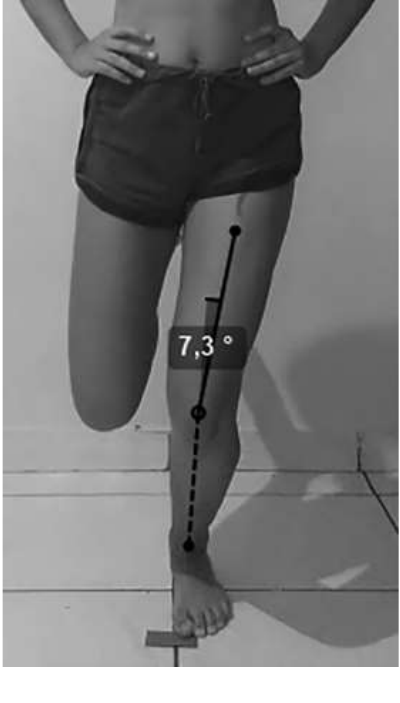
Figure 1 Measurement of the Knee Frontal Plane Projection Angle